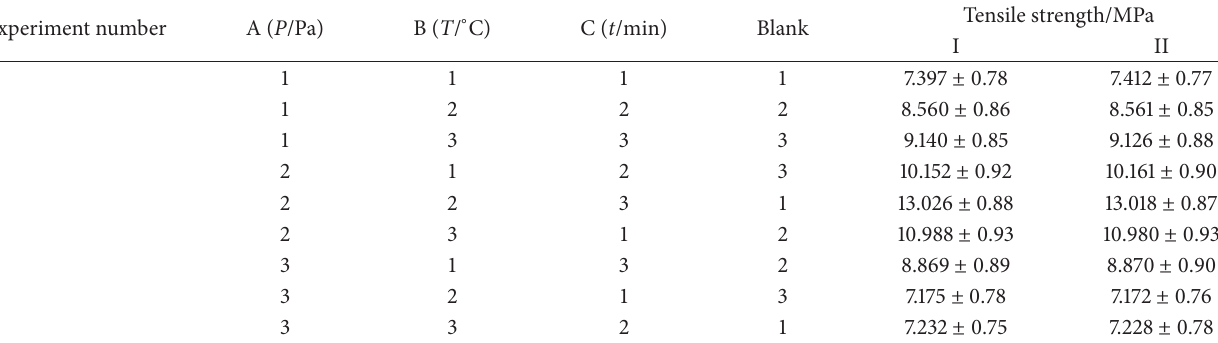
Table 1: Design of experiment and measurement results of each index.